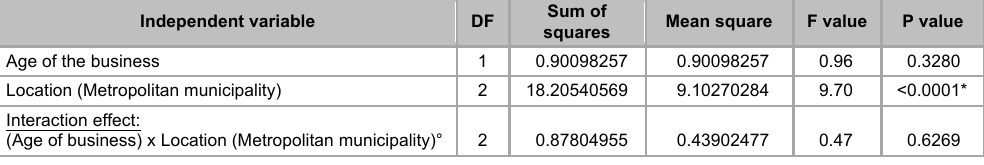
Tests of Between-Subjects Effects for the factor “Outputs of the small business policy” as dependent variable Independent variable DF